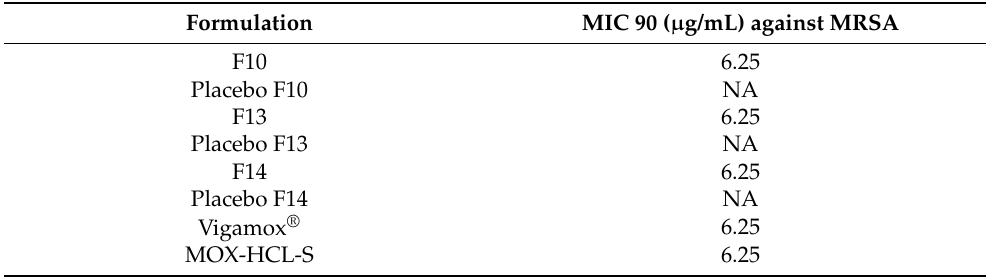
solution against